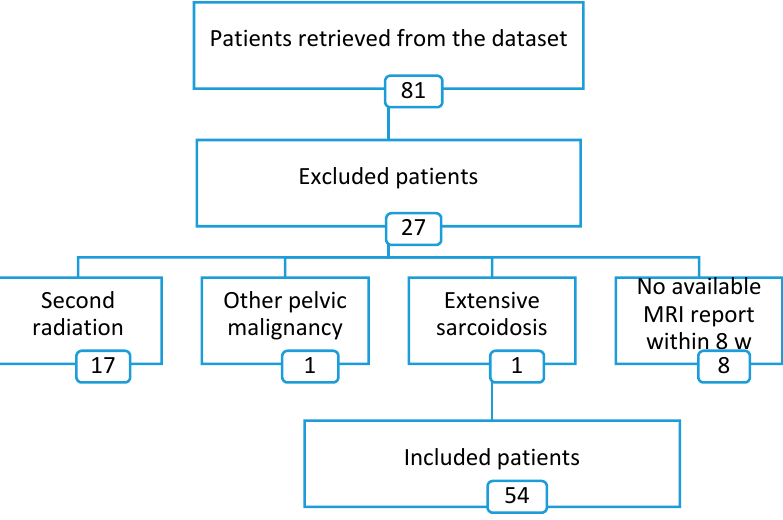
Figure 1. A flow diagram showing the process of exclusion of patients.